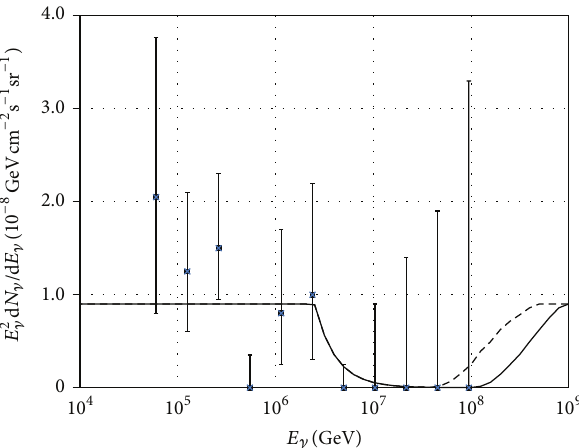
Figure 4: Three years of data from the IceCube experiment showing flux d 𝑁 ] / d 𝐸 ] multiplied by 𝐸 2 ] plotted against the neutrino energy 𝐸 ] . The solid and dashed curves show what would be expected for 𝐸 = 2.5 PeV threshold, and two 𝐸 −2 th ] power law for the flux, with arbitrarily assumed values for the source distance, 𝐿 (dashed curve) and 𝐿/2 (solid curve). The drop to zero above 𝐸 th only occurs for those neutrino flavors having a tachyonic mass consistent with a 2.5 PeV